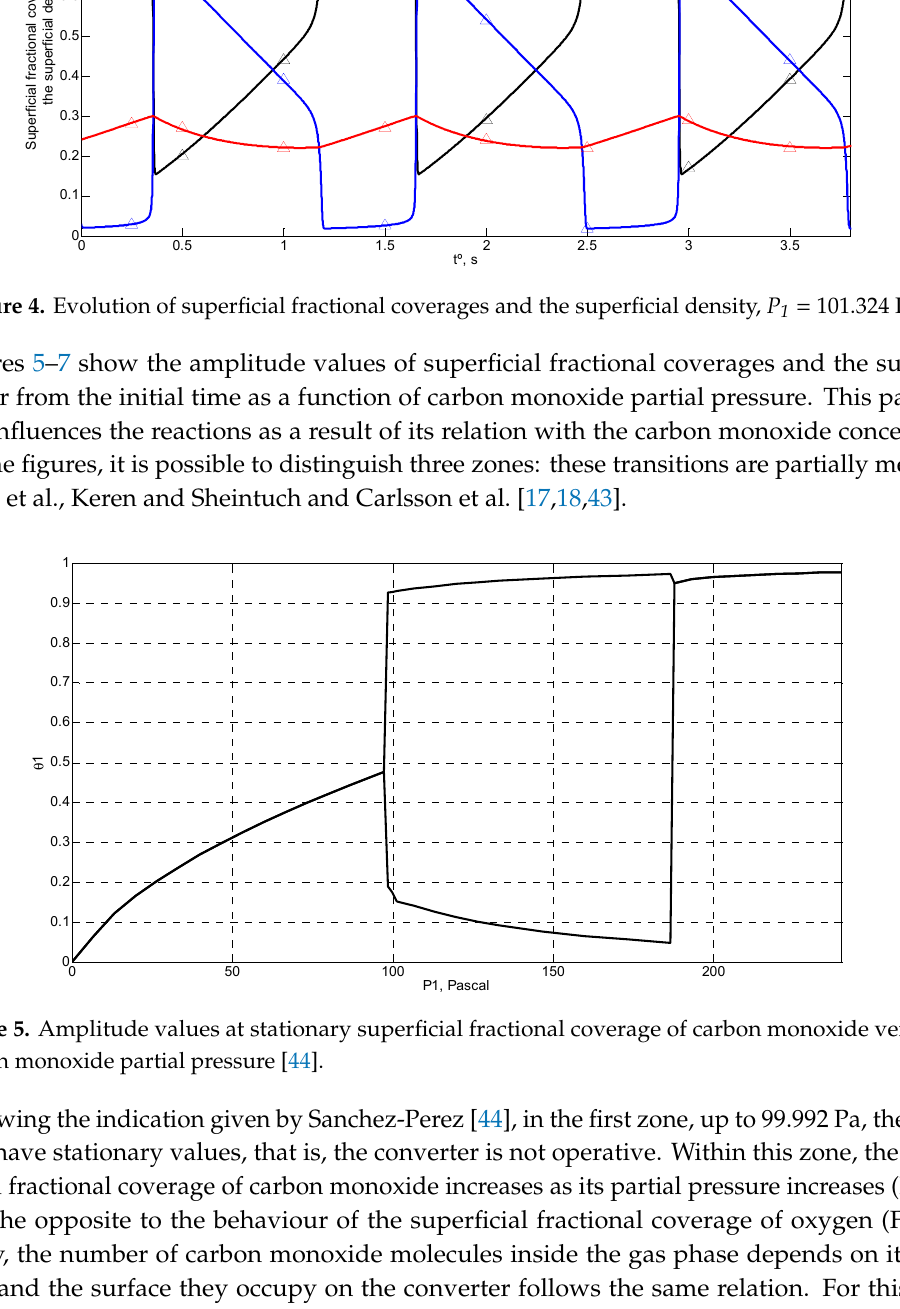
Figure 6. Amplitude values at stationary oxygen superficial fractional coverage versus carbon monoxide partial pressure [44].